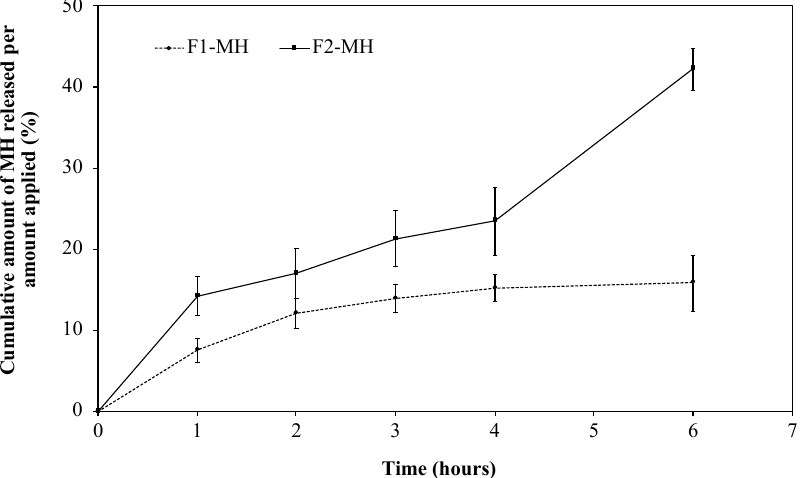
Figure 4. Release profiles of MH from the semi-solid hydrogel F1-MH ( • ) and the fluid hydrogel F2-MH ( (cid:4) ), using vertical Franz diffusion cells (mean ± SD; n = 6).